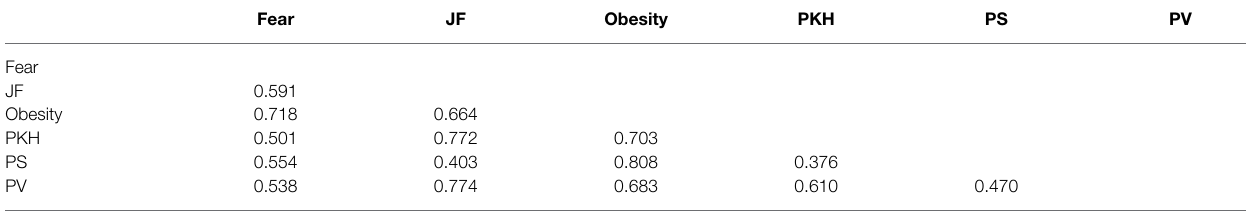
TABLE 3 | HTMT ratio.